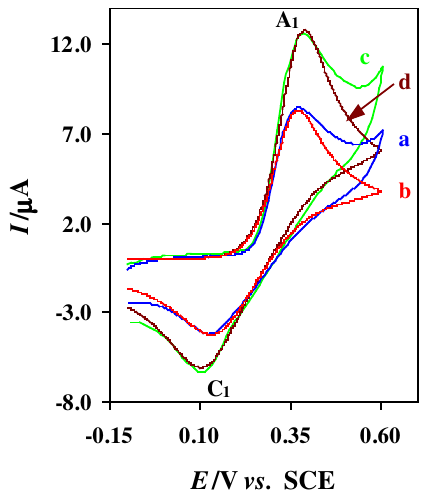
Figure 4. Experimental and simulated cyclic voltammograms of thiourea at alumina modified Pt electrode in acetate buffer solution (C = 0.15 M, pH = 4.5). (a) and (c): experimental, (b) and (d): simulated cyclic voltammograms. (a) and (b) scan rate 50 mV/s, (c) and (d) scan rate 120 mV/s. Thiourea concentration, 0.75 mM.